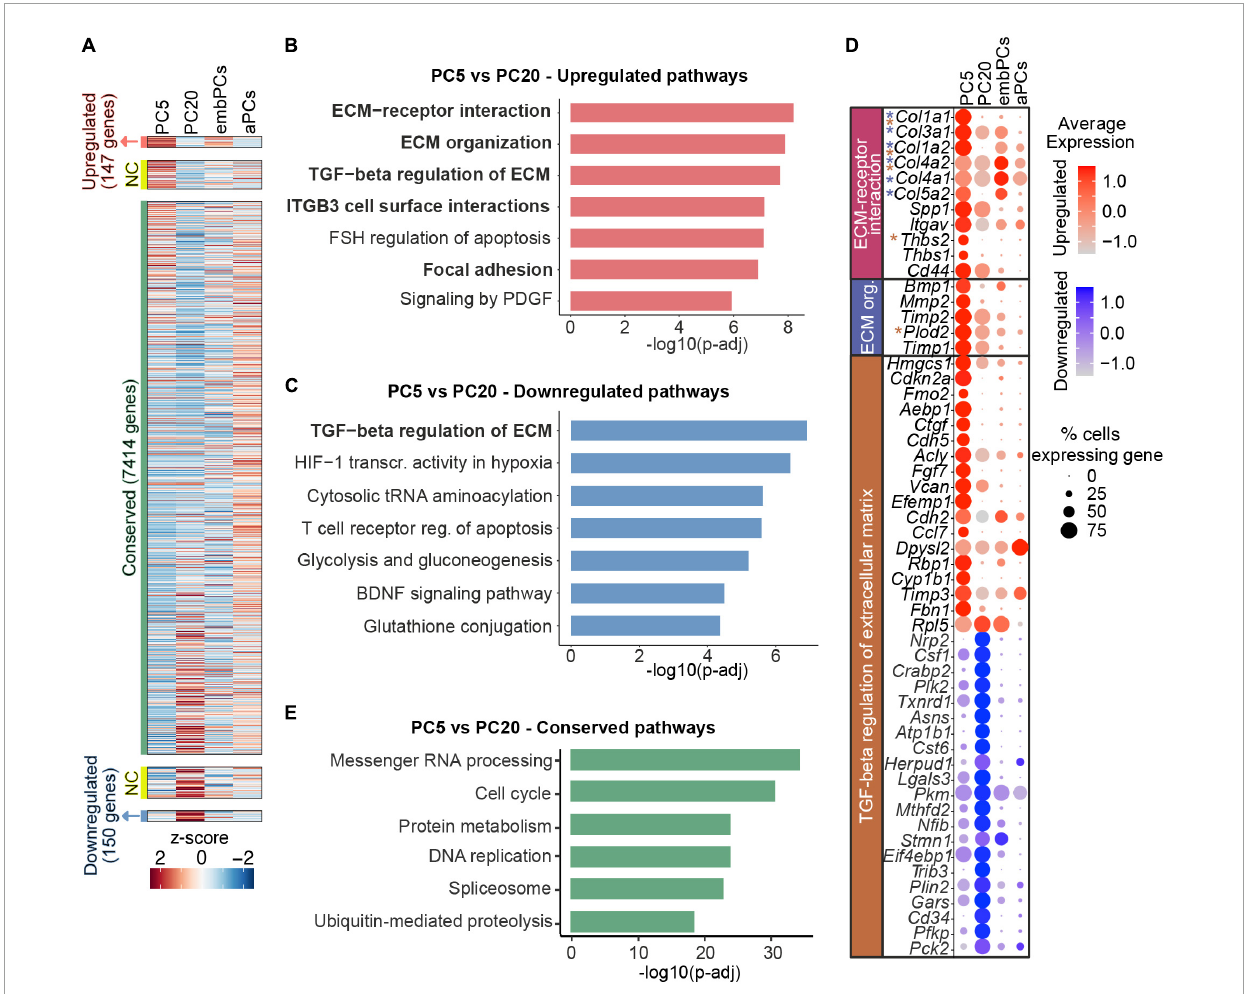
FIGURE4 Long-term PC culture results in reduction of collagen expression. (A) Heatmap representing enriched expression of genes in PC5 and PC20. Colors represent the average z-score of a cluster for each gene. NC indicates not considered genes (0.5 < log 2 FC < 1 or–1 < log 2 FC < –0.5). (B) BioPlanet annotated pathways significantly upregulated in PC5 vs. PC20. (C) BioPlanet annotated pathways significantly downregulated in PC5 vs. PC20. (D) Dot plot representing the average expression of deregulated genes belonging to up/downregulated pathways in PC5. Color scales indicate if the gene is upregulated (red) or downregulated (blue) in PC5 vs. PC20. Genes with asterisks are also part of other deregulated pathways (i.e., blue for the ECM organization pathway, and brown for the TGF-beta regulation of extracellular matrix). (E) BioPlanet annotated pathways conserved in PC5 vs. PC20. aPCs, adult brain pericytes; ECM, extracellular matrix; embPCs, embryonic brain pericytes; NC, not considered; org., organization; PCs, pericytes; PC5, passage 5 pericytes; PC20, passage 20 pericytes; TGF, transforming growth